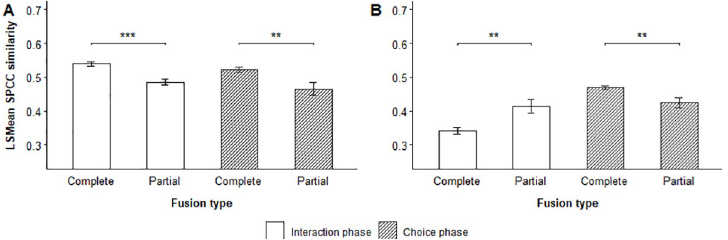
Fig 4. Effect of fusion type on stimulus-response similarity. LSMean ( ± SE) spectrographic cross-correlation (SPCC) similarity between stimulus calls and focal flock responses emitted during the interaction and choice phase of (A) male-male and (B) male-female trials that resulted in partial and complete fusions with a stimulus individual. Significant pairwise comparisons are indicated with asterisks.